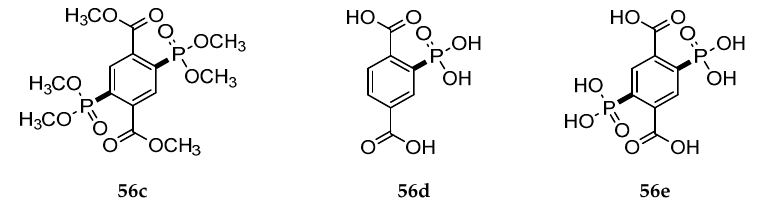
Figure 27. Chemical structures of compounds 56c to 56e .